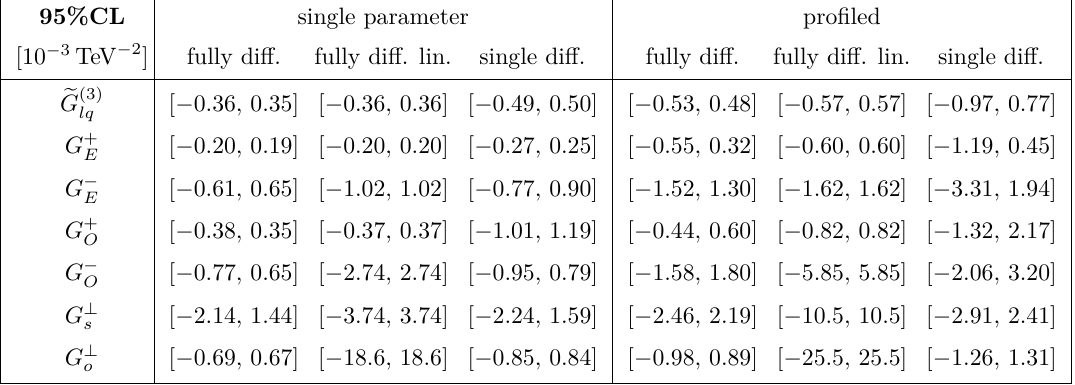
Table 2 . 95% CL projected bounds (in 10 − 3 TeV − 2 units) for the seven coefficients e G (3) and G ⊥ . The first three bounds correspond to single-operator fits, in which all other parameters s,o are set to zero, while the last three are profiled over the other parameters. For each set of bounds the three columns correspond to the complete fully-differential fit, the linearized one and the single- differential measurement fit.